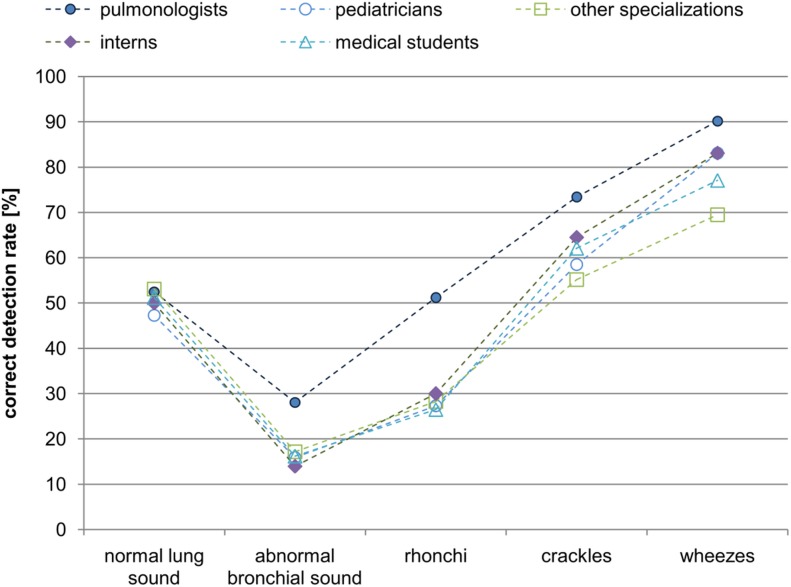
The percentage of correct detection of the grouped sound classes (main classes, Table 3) by physicians of various specializations.To emphasize the differences, the points for individual groups are connected by lines.